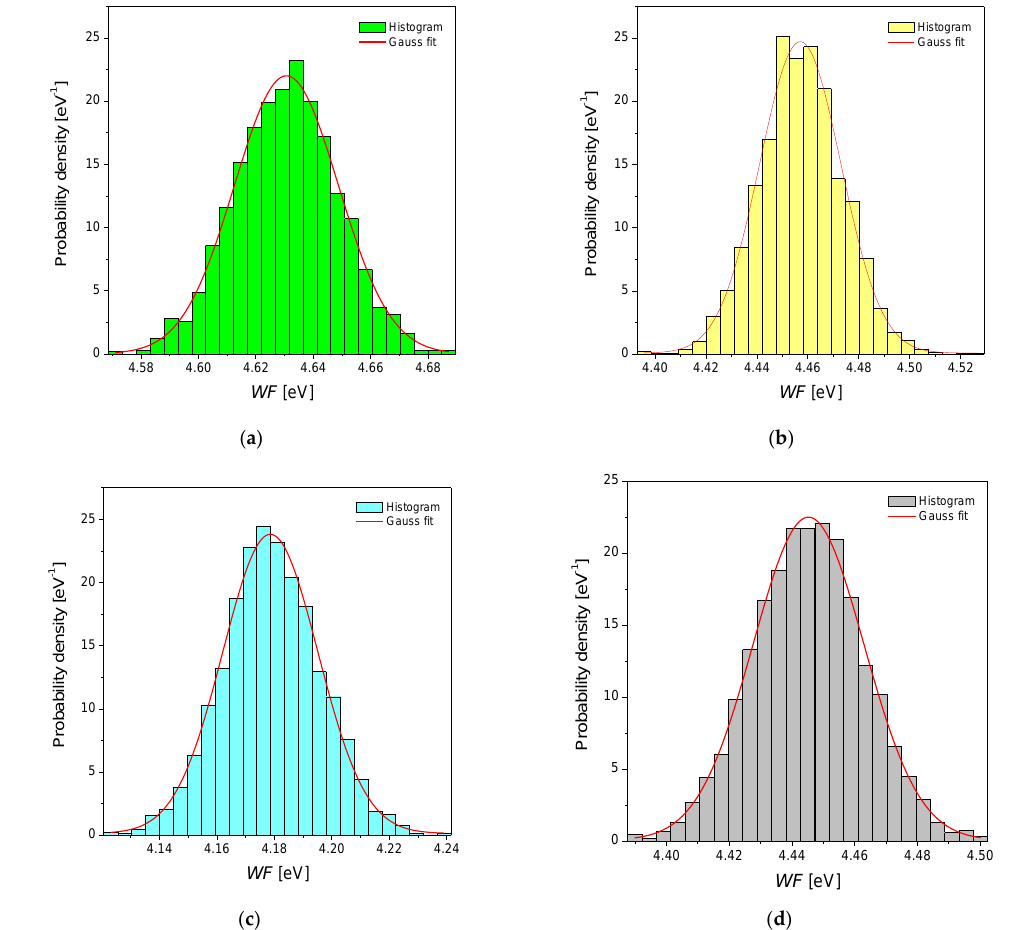
Figure 3. Work function maps determined for as-deposited electrodes: ( a ) Pd; ( b ) Pd-Rh; ( c ) Pd-Ru; ( d ) Pd-Pt.